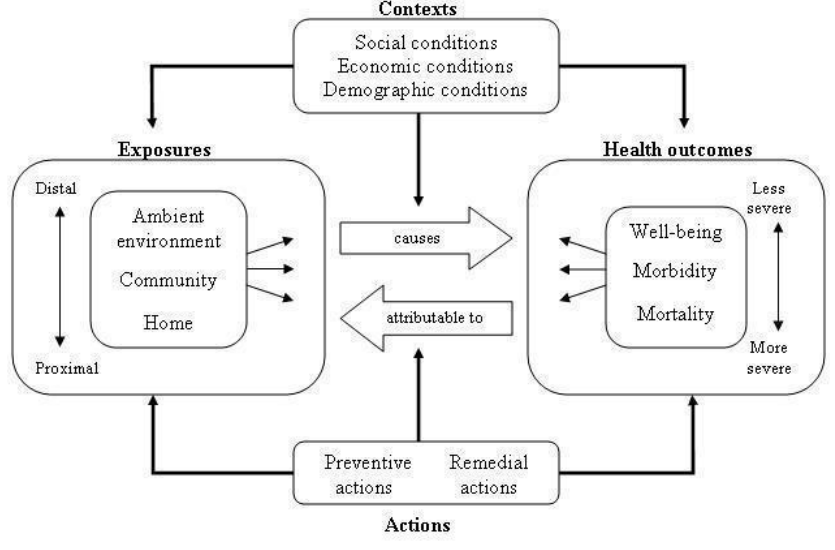
Figure 6. Multiple Exposures-Multiple Effects framework (reproduced with